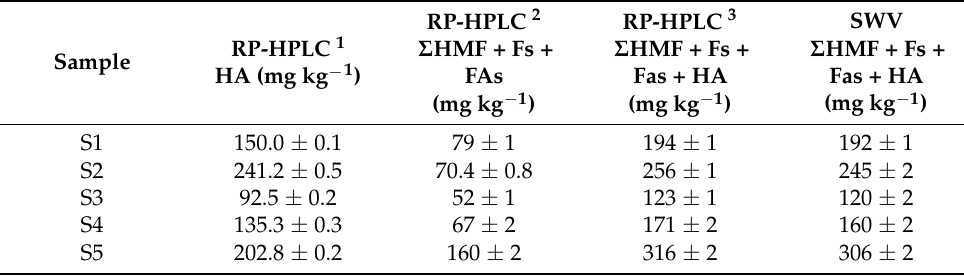
Table 8. RP-HPLC determination of homogentisic acid (HA) in the strawberry tree honeys and comparison among results obtained by means of both RP-HPLC and SWV methods.